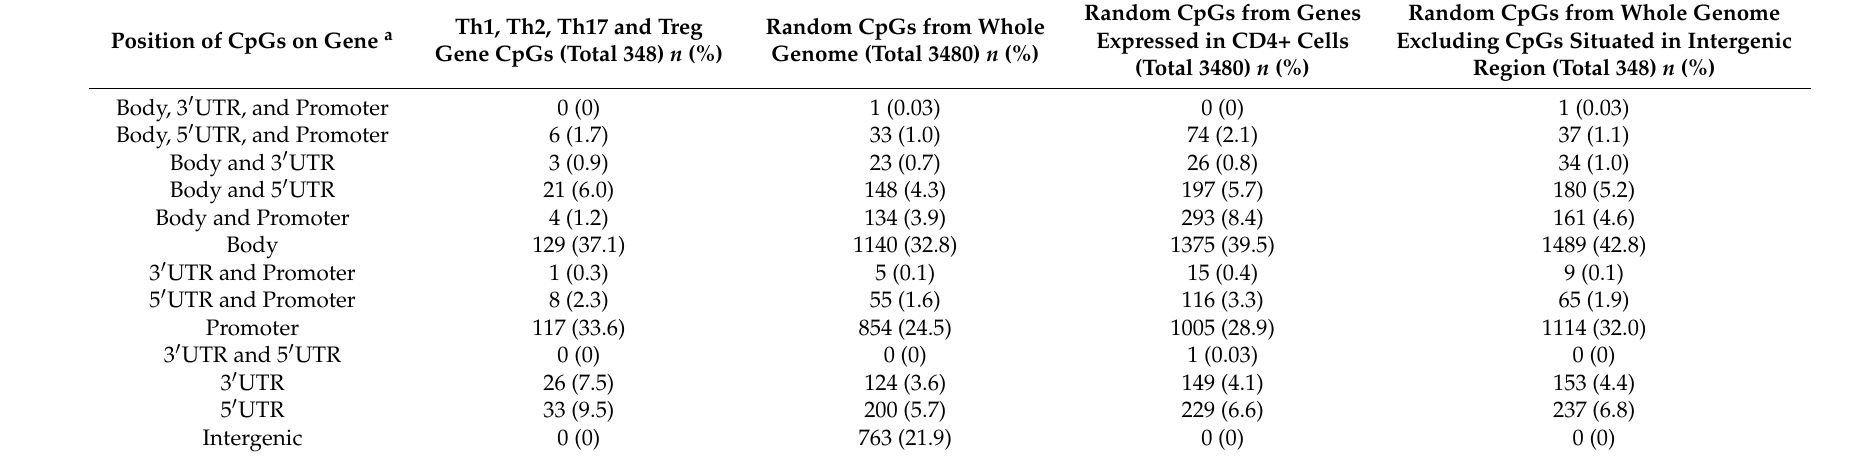
Table 7. Number and proportion of CpG sites according to their position on the